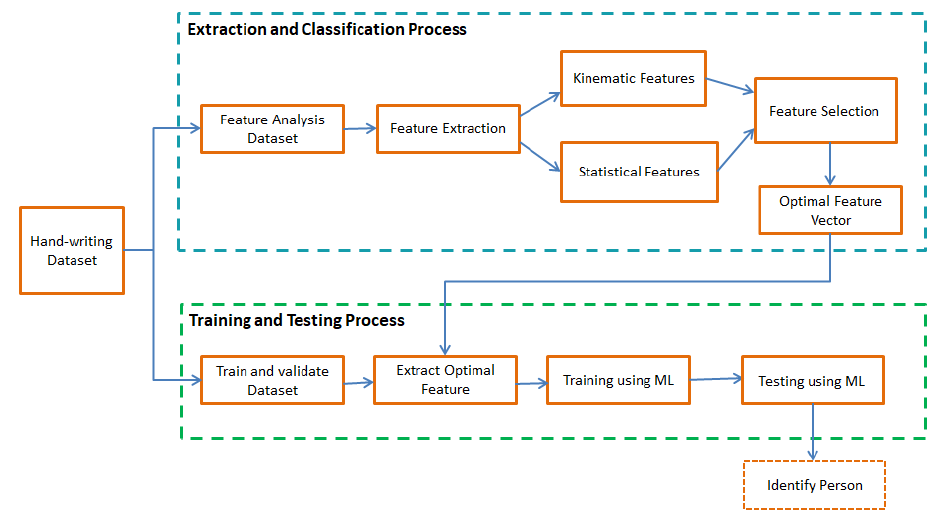
Figure 1. General Architecture of Proposed Model.